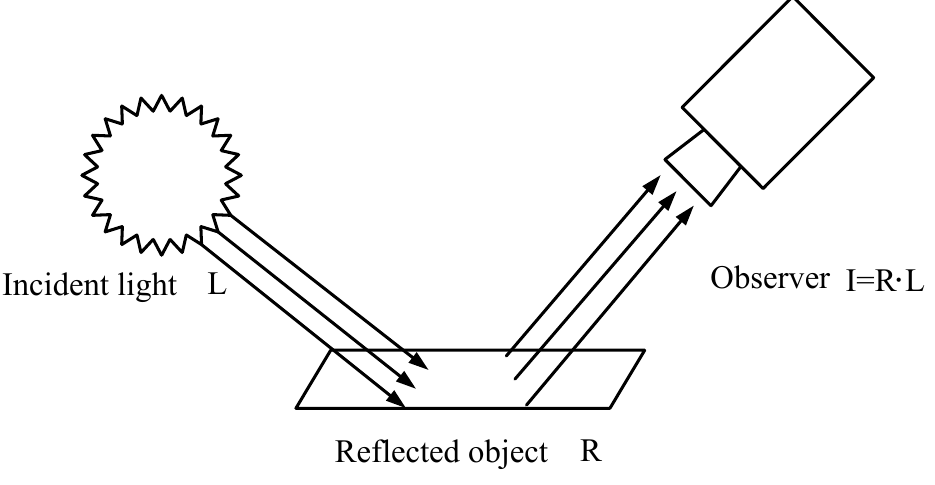
Figure 1. Retinex theoretical object imaging